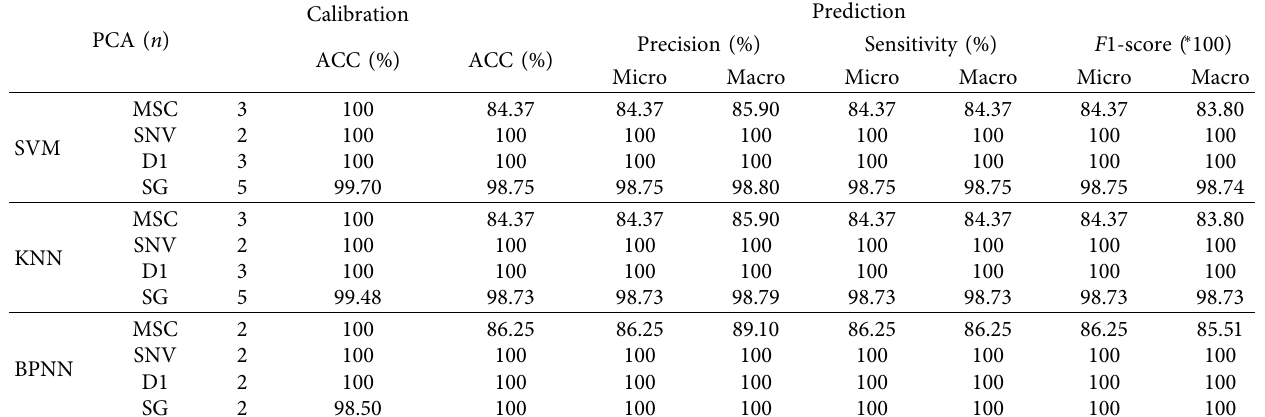
Figure 4: Confusion matrix for the prediction of transparent samples with the SVM model: (a) SNV-PCA, (b) MSC-PCA, (c) D1-PCA, and (d) SG-PCA (label0: PC; label1: PET; label2: PS; label3: PVC). Table 3: Performance of classification models for transparent commercial plastic